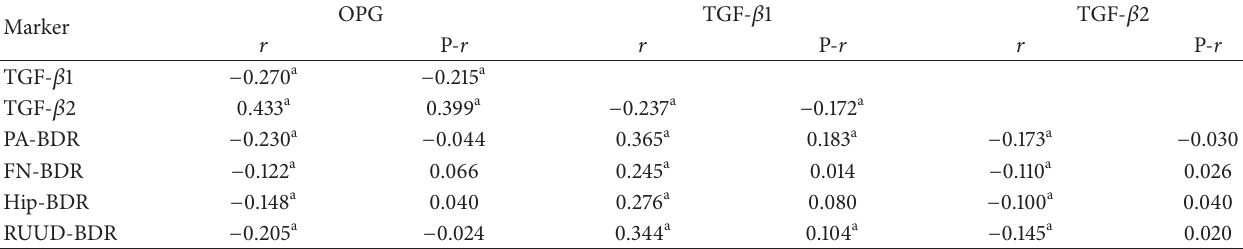
Table 3: Correlation coefficients ( 𝑟 ) for serums OPG, TGF- 𝛽 1, and TGF- 𝛽 2 with BDR at various skeletal sites in native Chinese women. Marker